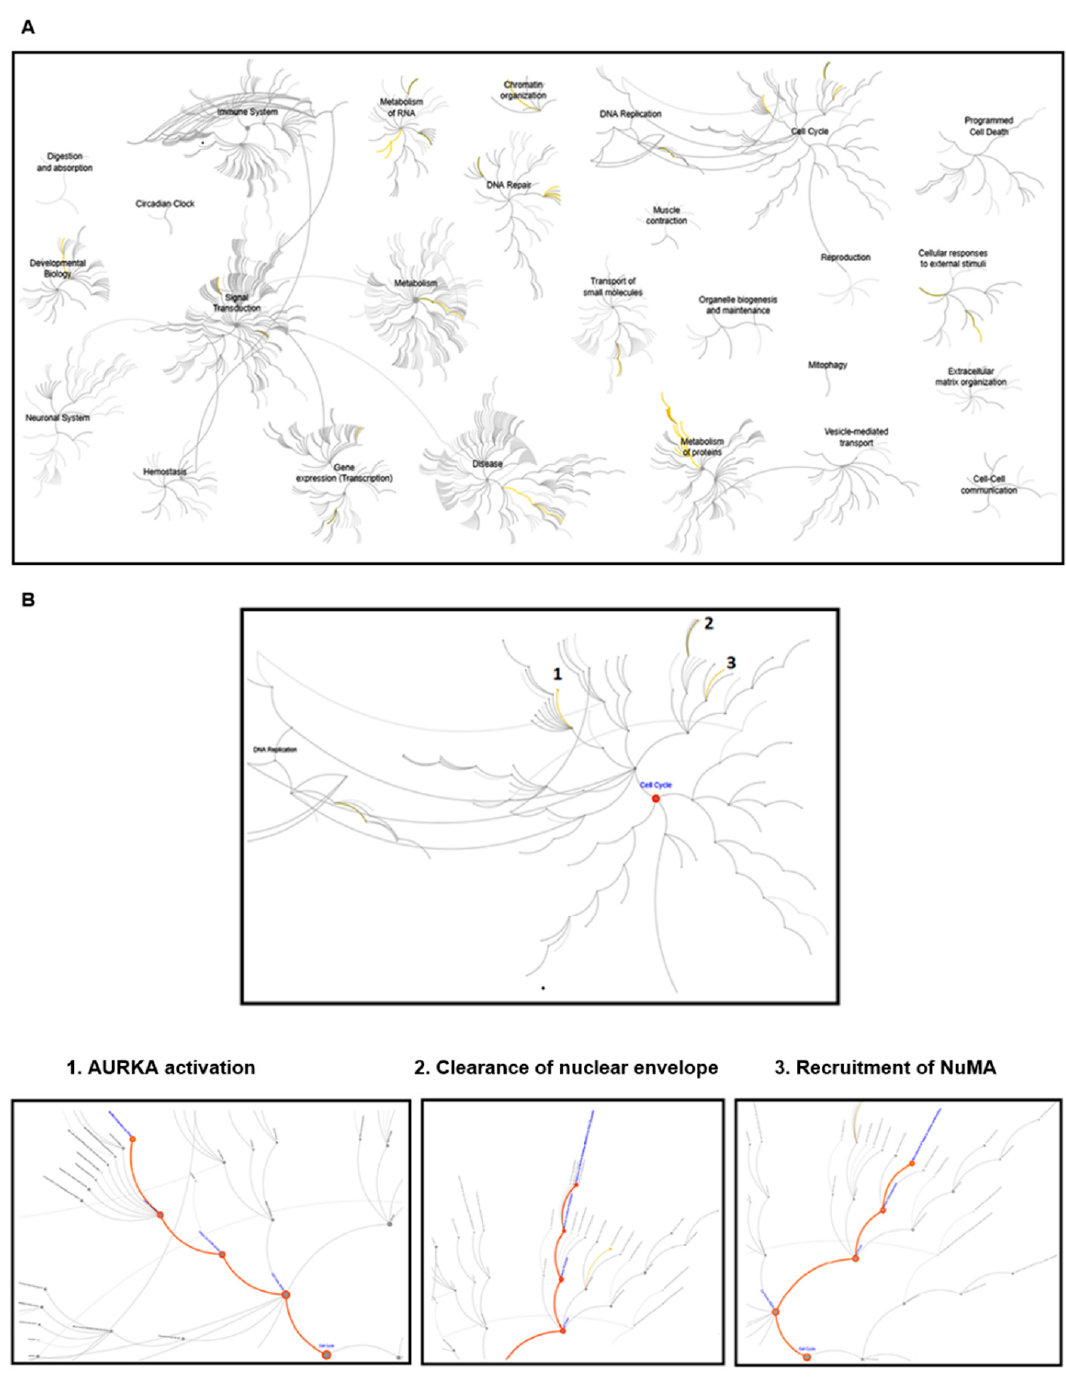
Figure 1. The results of the reactome pathway analysis. The protein extracts from the HEK293 cells were used for the immunoprecipitation study. There were 202 proteins with a two-fold increase (Klotho Ab vs. non-specific IgG) identified by the immunoprecipitation (IP) / LC / MS / MS analysis, and followed by reactome pathway analysis. ( A ) Plot of the pathways with p value less than 0.05. The significant pathways were marked as yellow lines. ( B ) Plots of the pathways of the cell cycle and mitosis. Three significant pathways of cell cycle and mitosis, Aurora kinase A (AURKA) activation, clearance of nuclear envelope, and recruitment of NuMA are shown and marked with orange